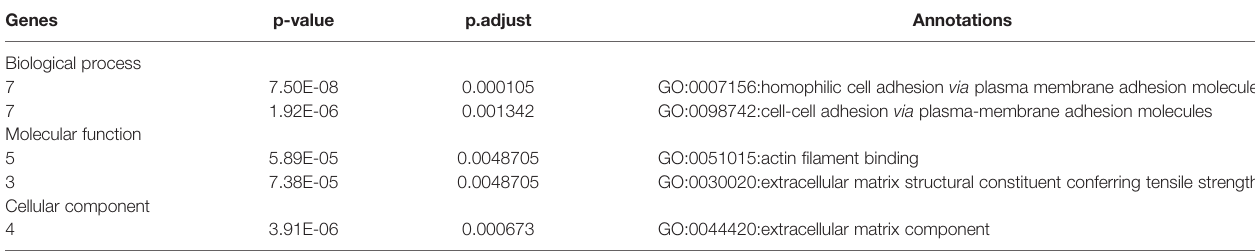
TABLE 2 | GO analysis of 45 survival-related mutated genes (partial data). Genes p-value